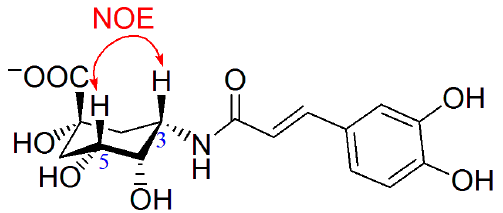
Figure 1. NOE interaction defining the configuration of C-3 in 6a .